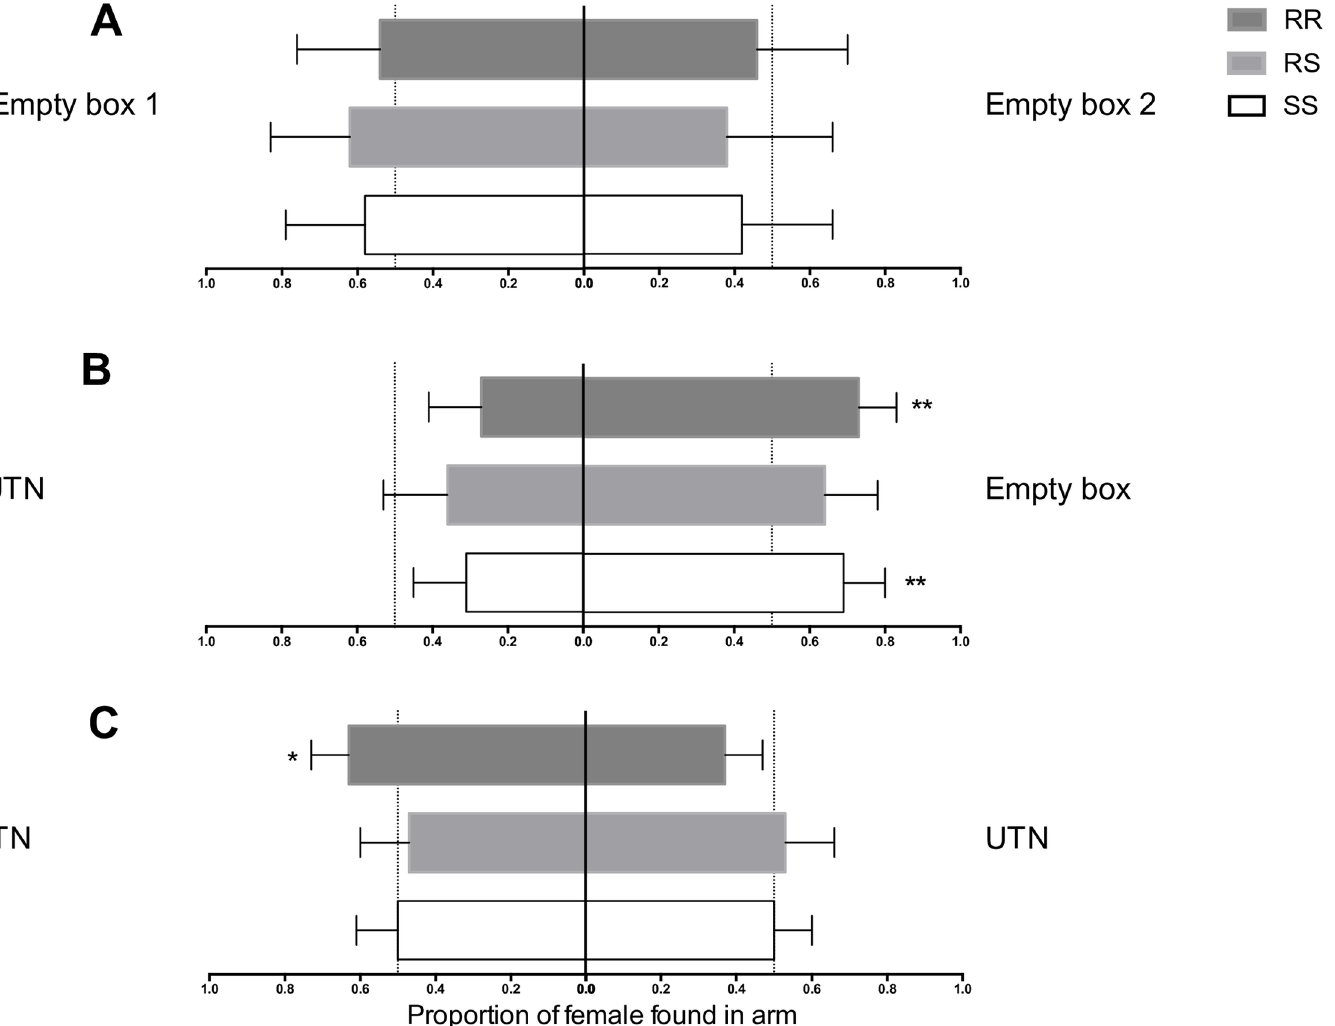
Fig 3. Relative attractiveness rates. RA: numberof mosquitoesfound in one arm relative to the total number of mosquitoesfound in both arms. (A) Experiment 2 (rabbit only). (B) Experiment 3 (rabbit + UTN or empty box). (C) Experiment 4 (Rabbit+ UTN or ITN). Asterisks show difference to 0.5, traducing a choice for one treatment rather than the other. Error bars show the 95% CI; ** p (cid:20) 0.01, * p (cid:20) 0.05.UTN: Untreatednet, ITN: Insecticide-treated net. SS: homozygotefor the L1014Sallele(insecticide-susceptible), RS: heterozygous for the L1014F allele, RR: homozygous for L1014Fallele (insecticide-